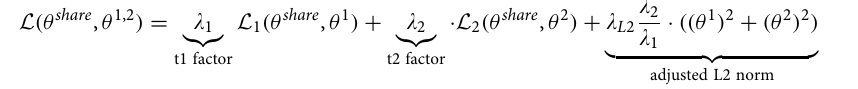
6 , where the 7th detector has the lowest energy value. = 7 , where the 8th detector has the =